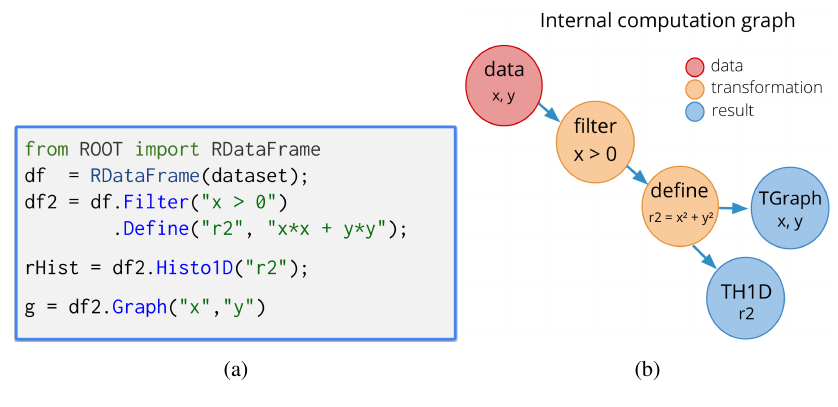
Figure 1: Simple operations on a dataset using RDataFrame. (a): analysis code using PyROOT, ROOT’s Python API. (b): the corresponding computation